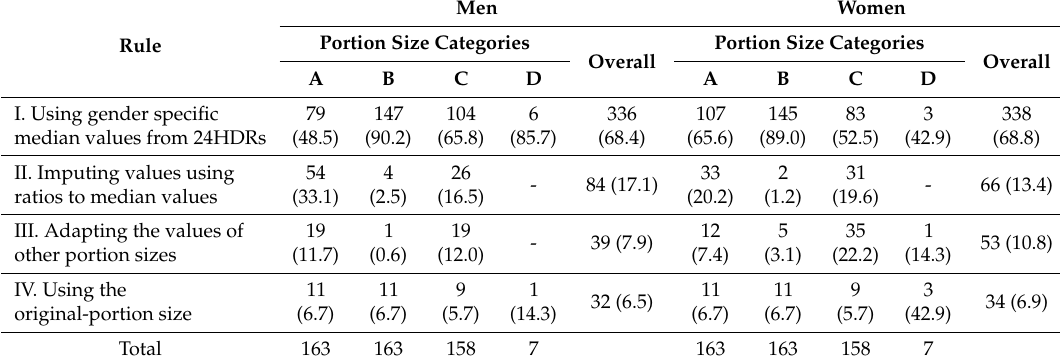
Table 2. Number (%) of food and beverage items by portion size categories on the quantitative food frequency questionnaire that used each rule to determine gender specific-portion sizes in the Multiethnic Cohort. 24HDRs—24 h dietary recalls.